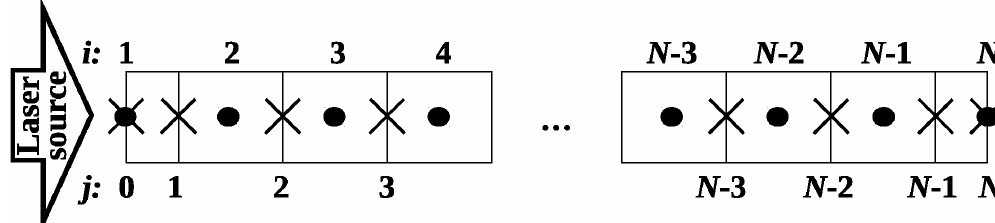
Figure 1. The finite-difference grid mesh for the solution of the n TTM model equations. Symbol “ • ” indicates the grid points for n , Te , T a , and E g ( i = 1,2,..., N ); symbol “ × ” indicates the grid points for (cid:126) J , (cid:126) W , D , and k ∂ T a ( j = 1,2,..., N + a ∂ z